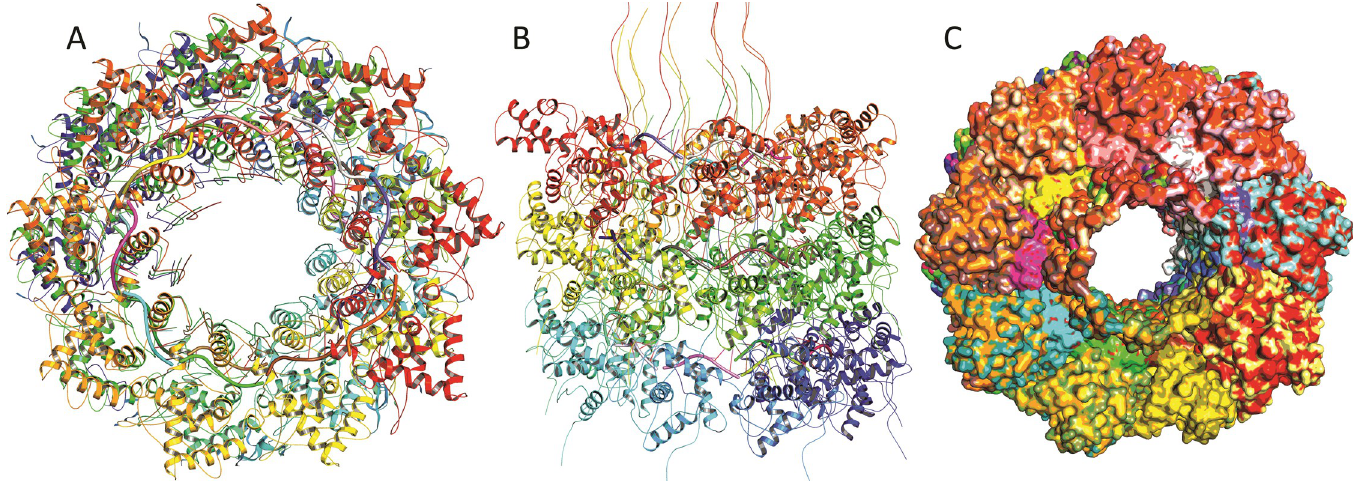
Fig 5. Oligomeric assembly of 24 identical subunits of CP with RNA (A) top, (B) front and (C) surface representation).